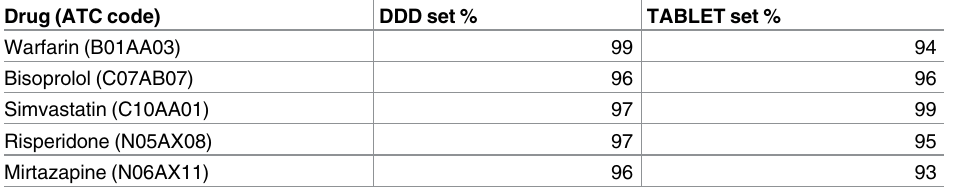
Table 1. Percentage of equal evaluations by two reviewersin two evaluation sets, referredas DDD set and TABLET